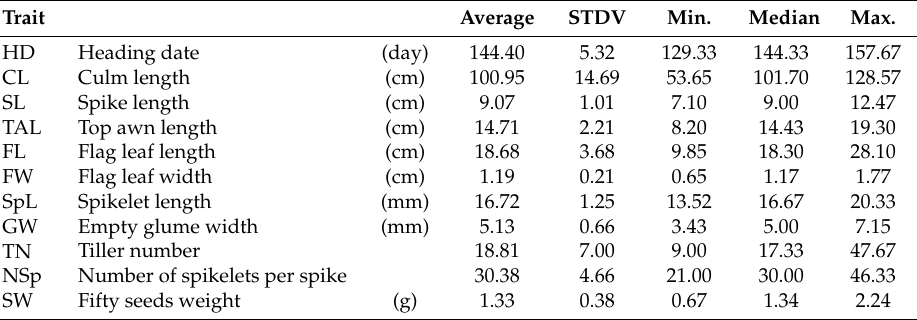
Table 1. Variation in 11 morphological traits in T. dicocciodes